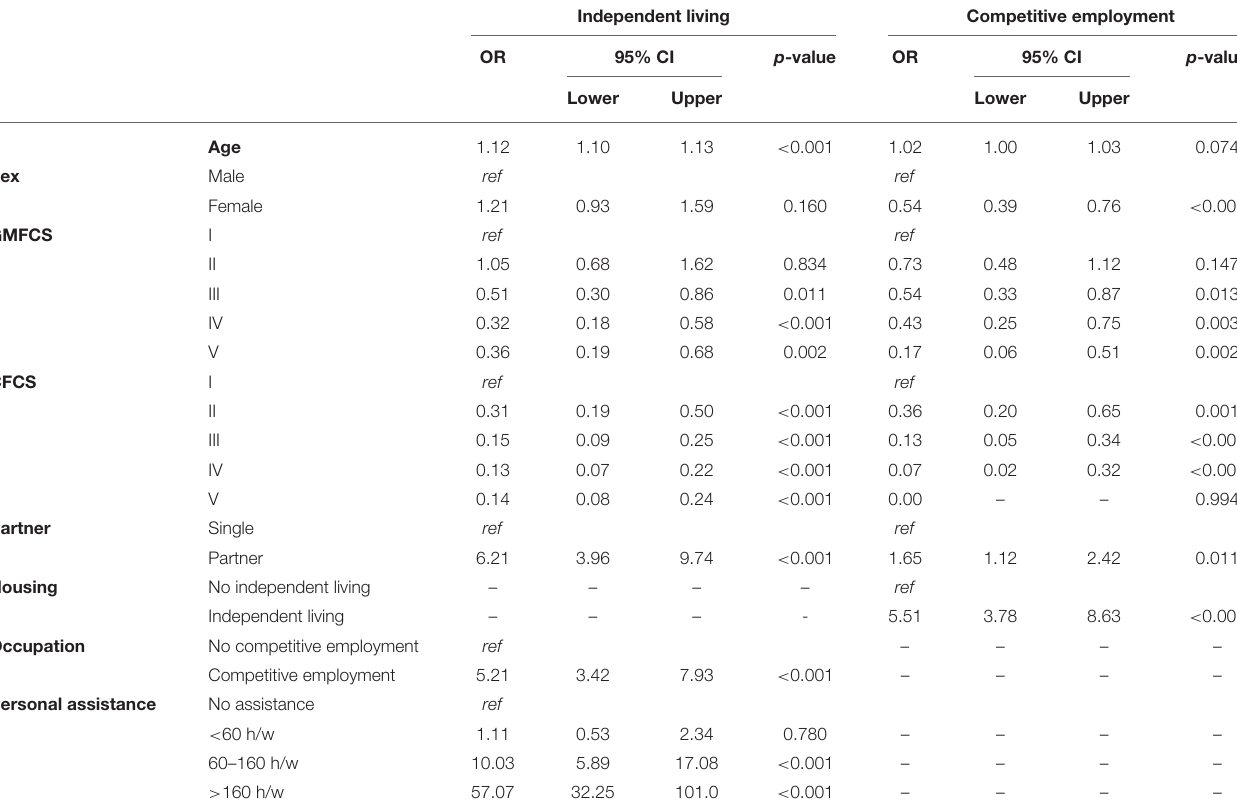
TABLE 5 | Binary logistic regression analyses for independent living and competitive employment presented as odds ratios (ORs) with 95% confidence intervals